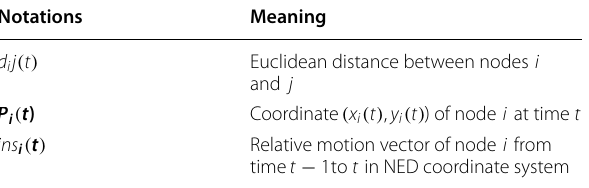
Table 1 Notations used in this